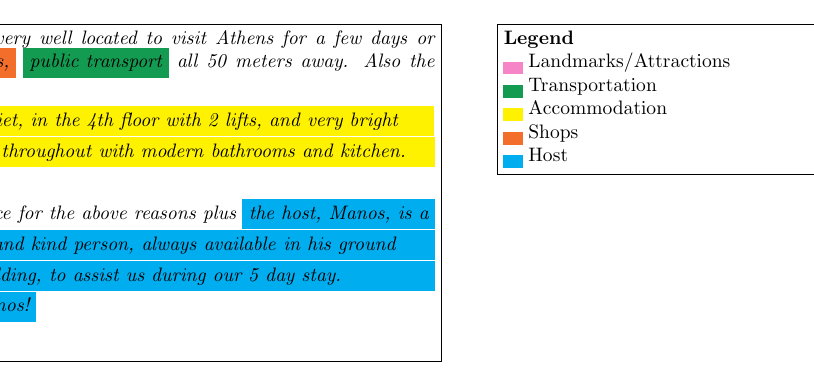
Figure 2. Example review from the dataset (color